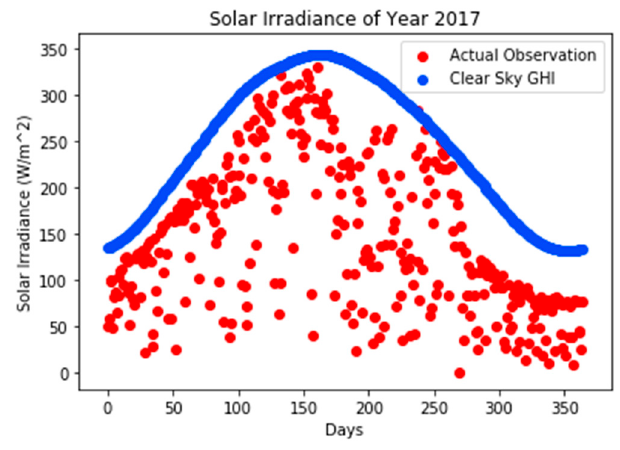
Figure 3. Clear sky GHI and observed radiation.